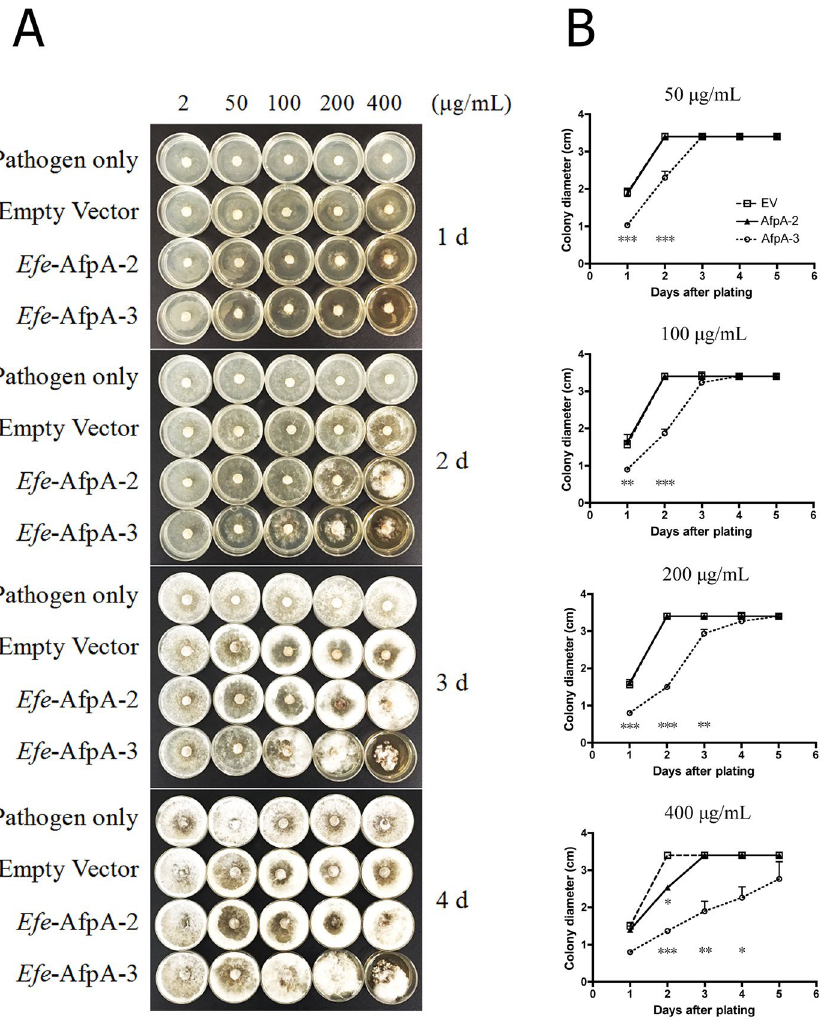
Figure 6. Antifungal activity assay of Efe -AfpA-2 and Efe -AfpA-3 purified from P . pastoris culture filtrates against S . homoeocarpa . The purified proteins, 2–400 μ g mL − 1 were incorporated into 35 mm PDA plates and 0.5 cm plugs of S . homoeocarpa were placed in the center of the plates. ( A ) Photographs of 35 mm plates 1–4 days after inoculation with S . homoeocarpa . ( B ) Colony diameter changes of S . homoeocarpa on the 35-mm plate 1–5 days after inoculation. Significant differences between constructs Efe -AfpA-2 and Efe -AfpA-3, each relative to the empty vector proteins, are indicated by *** ( P < 0.001), ** (P < 0.01), and * ( P < 0.05). Vertical bars are standard deviation values for diameter comparisons of each construct at a given day after